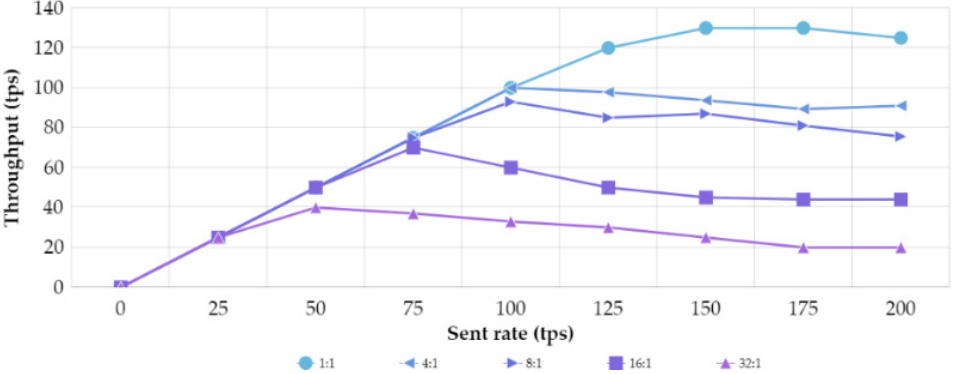
Figure 7. mbapSSI throughput behavior for different architectures.